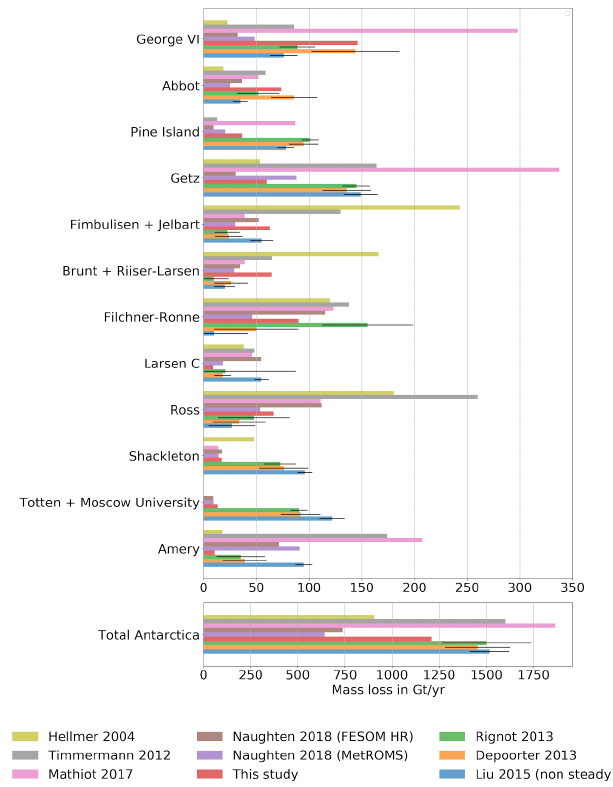
Figure 6. Ice shelf basal mass loss from models and satellite ob- servations (equiv. Table A1). Estimates of ice shelf basal mass loss for all of Antarctica and major ice shelves individually derived from previous ocean models (Hellmer, 2004; Timmermann et al., 2012; Mathiot et al., 2017; Naughten et al., 2018b), this study, and meth- ods combining satellite data with models of surface processes (Rig- not et al., 2013; Depoorter et al., 2013; Liu et al., 2015). Among the satellite studies, only Liu et al. (2015) avoid the assumption of a steady-state calving front when inferring basal conditions (see Liu et al., 2015, for